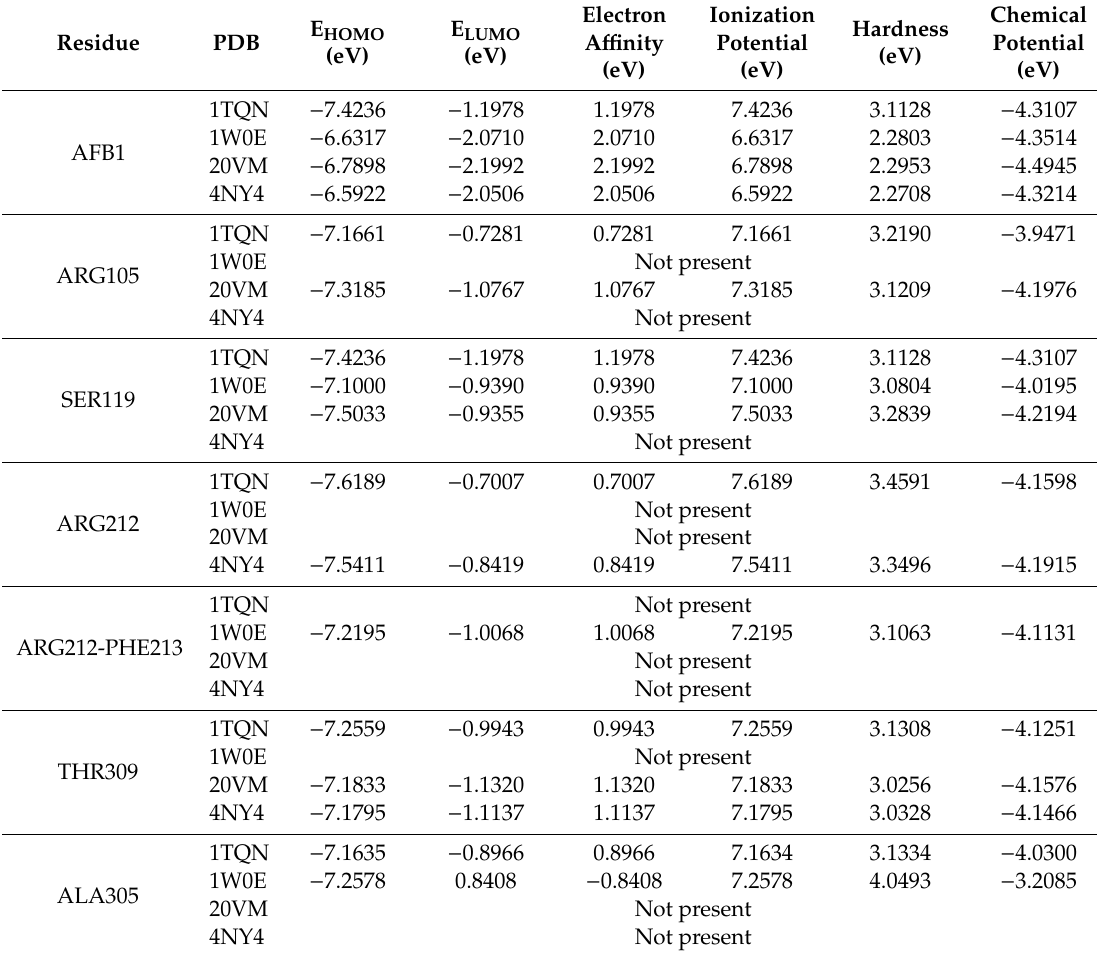
Table 5. Chemical reactivity parameters of amino acids present in the active sites of CYP3A4 (using di ff erent PDB IDs) provided by the interaction with aflatoxin